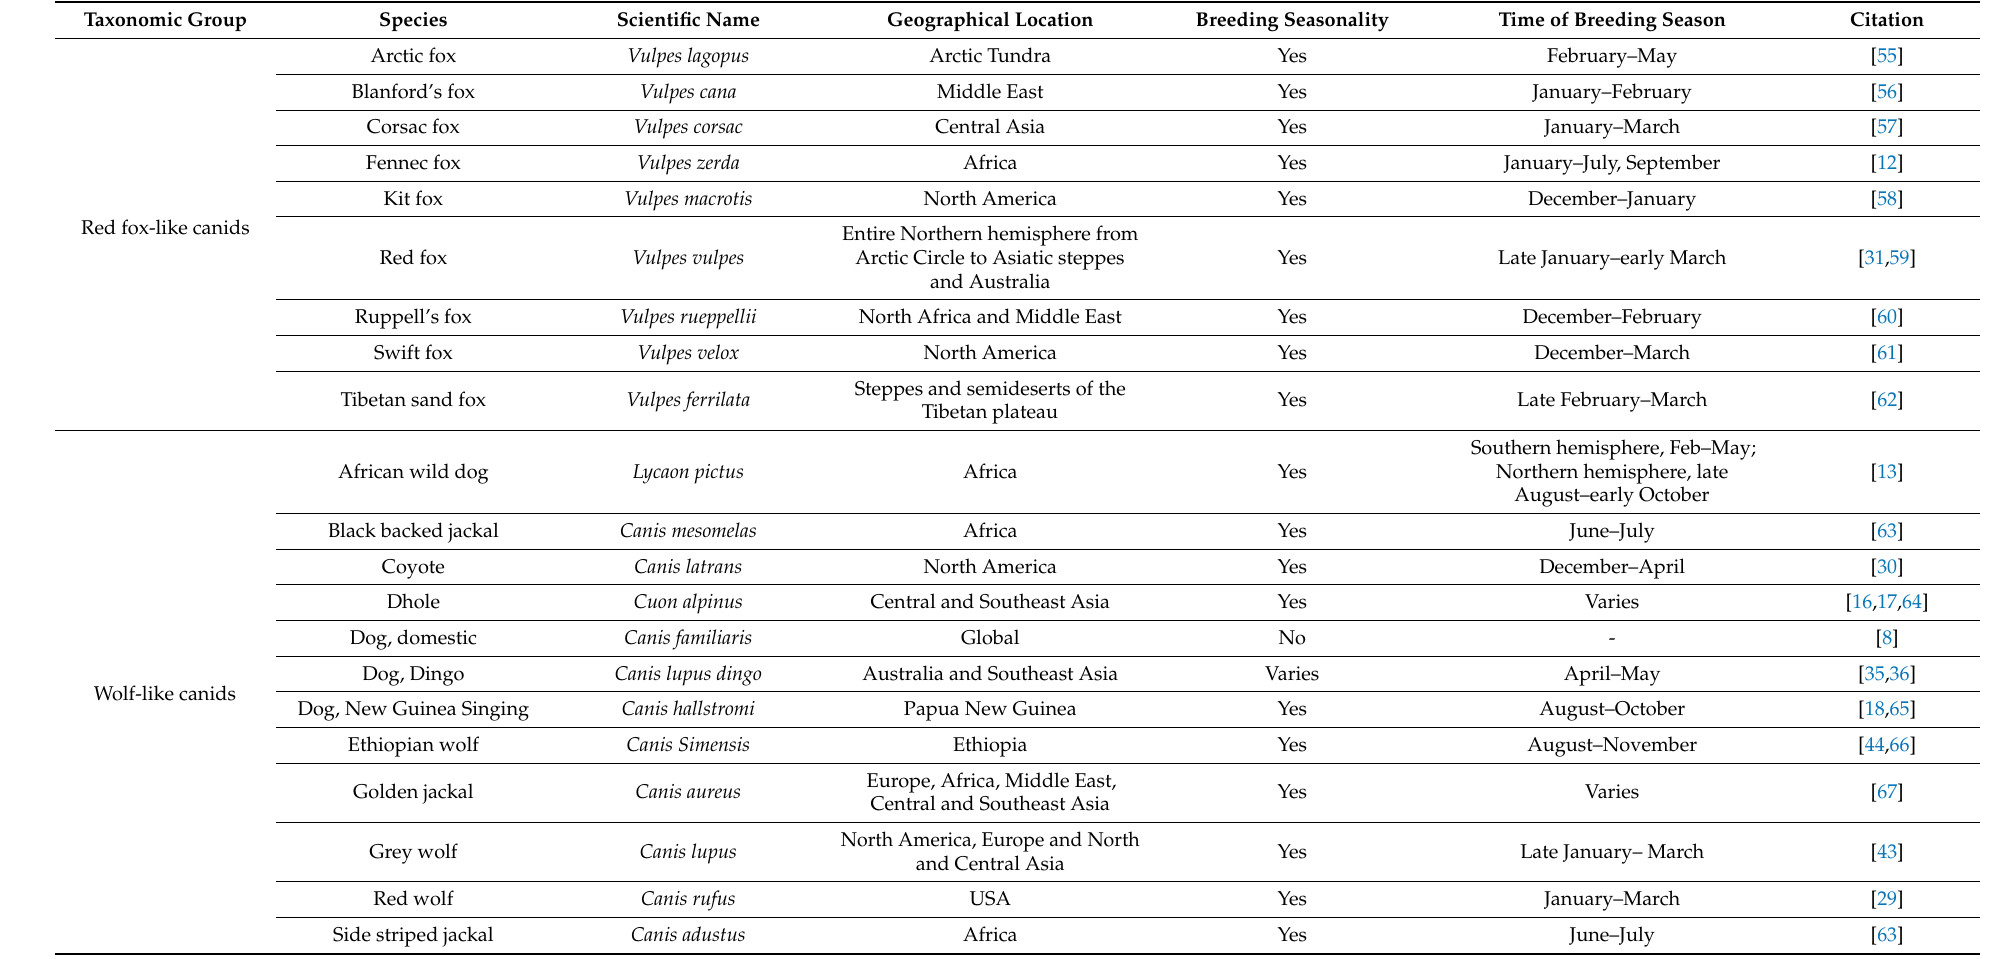
Table 1. Geographic location and published seasonality in Canidae, organized by taxonomic clade based on